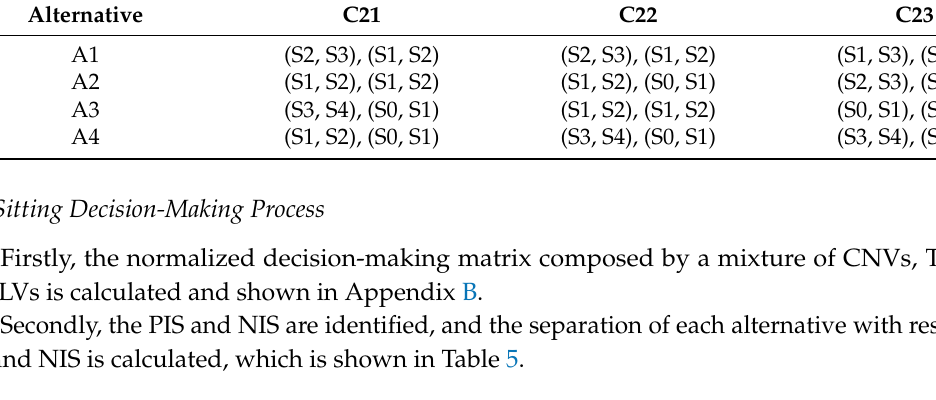
Table 5. The separation of each alternative from positive and negative ideal solution.